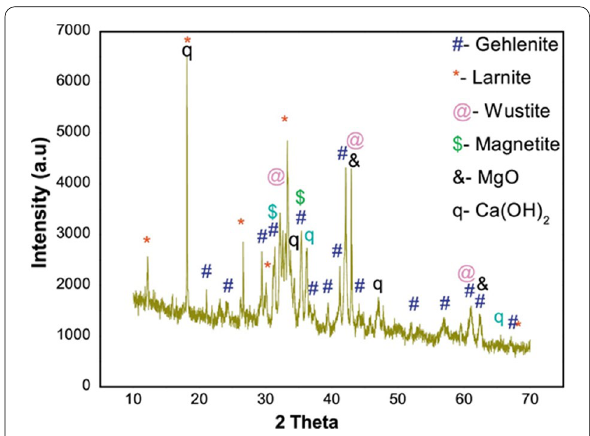
Fig. 7 XRD analysis of EAF slag (Singh et al.,